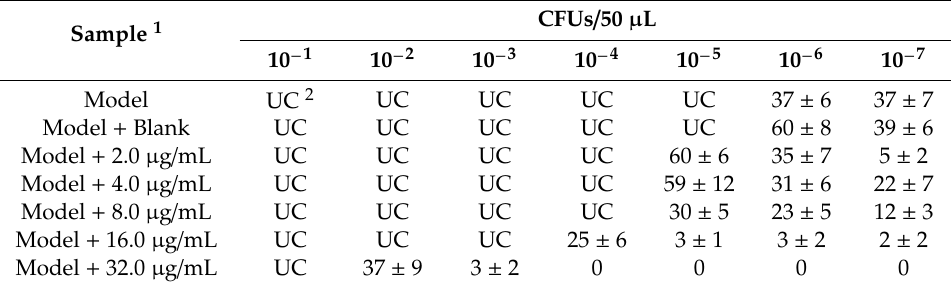
Figure 4. Confocal laser scanning microscopy of S. aureus mature biofilms treated with di ff erent concentrations of azalomycin F 5a . ( a ): Blank control; ( b ): 2.0 µ g / mL; ( c ): 4.0 µ g / mL; ( d ): 8.0 µ g / mL; ( e ): 16.0 µ g / mL; ( f ): 32.0 µ g / mL. Live and dead cells were, respectively, stained in green and red, and yellow meant the superposition of green and red. Table 1. Drop plate for counting colony-forming units (mean ± SD, n =